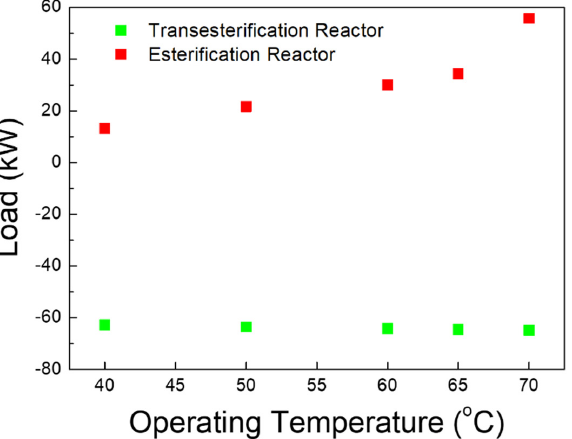
Figure 7. The effect of reactor operating temperature on the heating or cooling load of the transesterification reactor and esterification reactor. The positive value indicates a heating load, while a negative value indicates a cooling